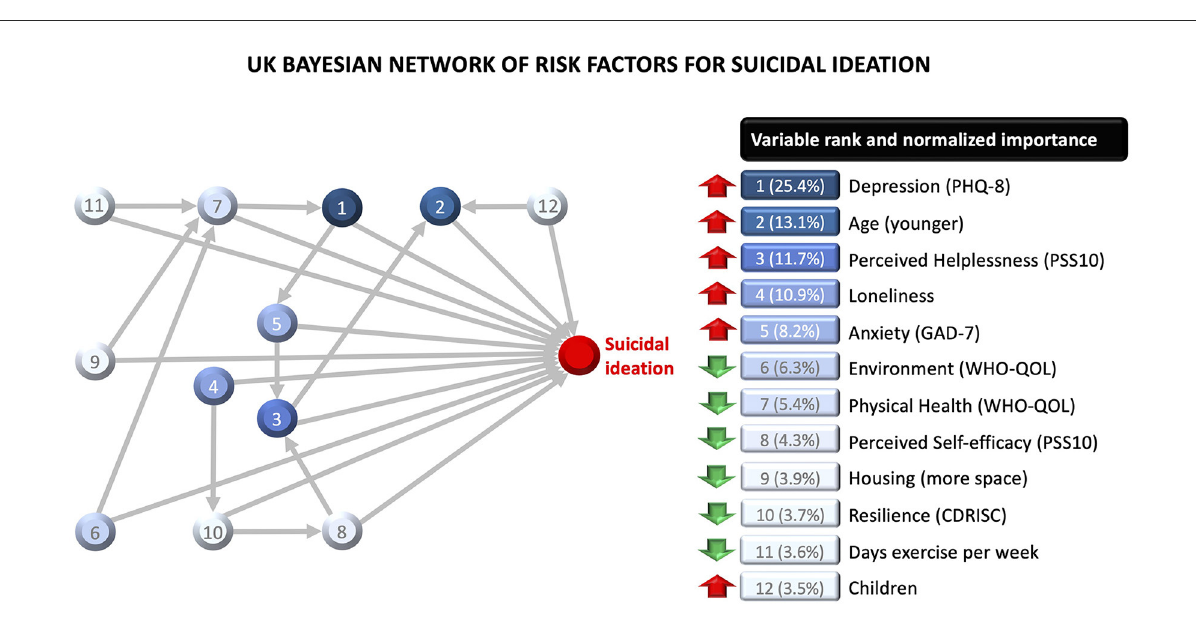
requiring care, exercise and perceived helplessness. The application of Bayesian network models enabled the discovery of complex interrelationships between protective and risk factors. Observed interactions indicate that suicidality is influenced by an interplay of relational (parenthood, loneliness, quality of relationships), health indicators (physical health, depression, anxiety, exercise) and